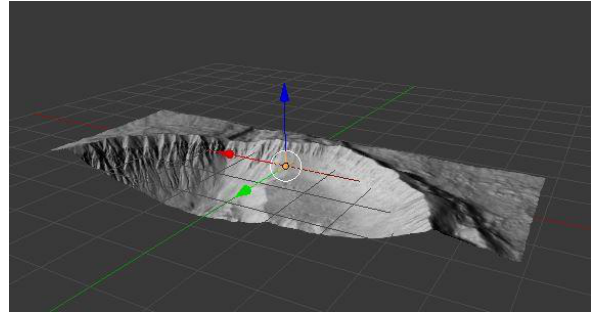
Figure 5 HiRiSe DTM of the Herschel Crater